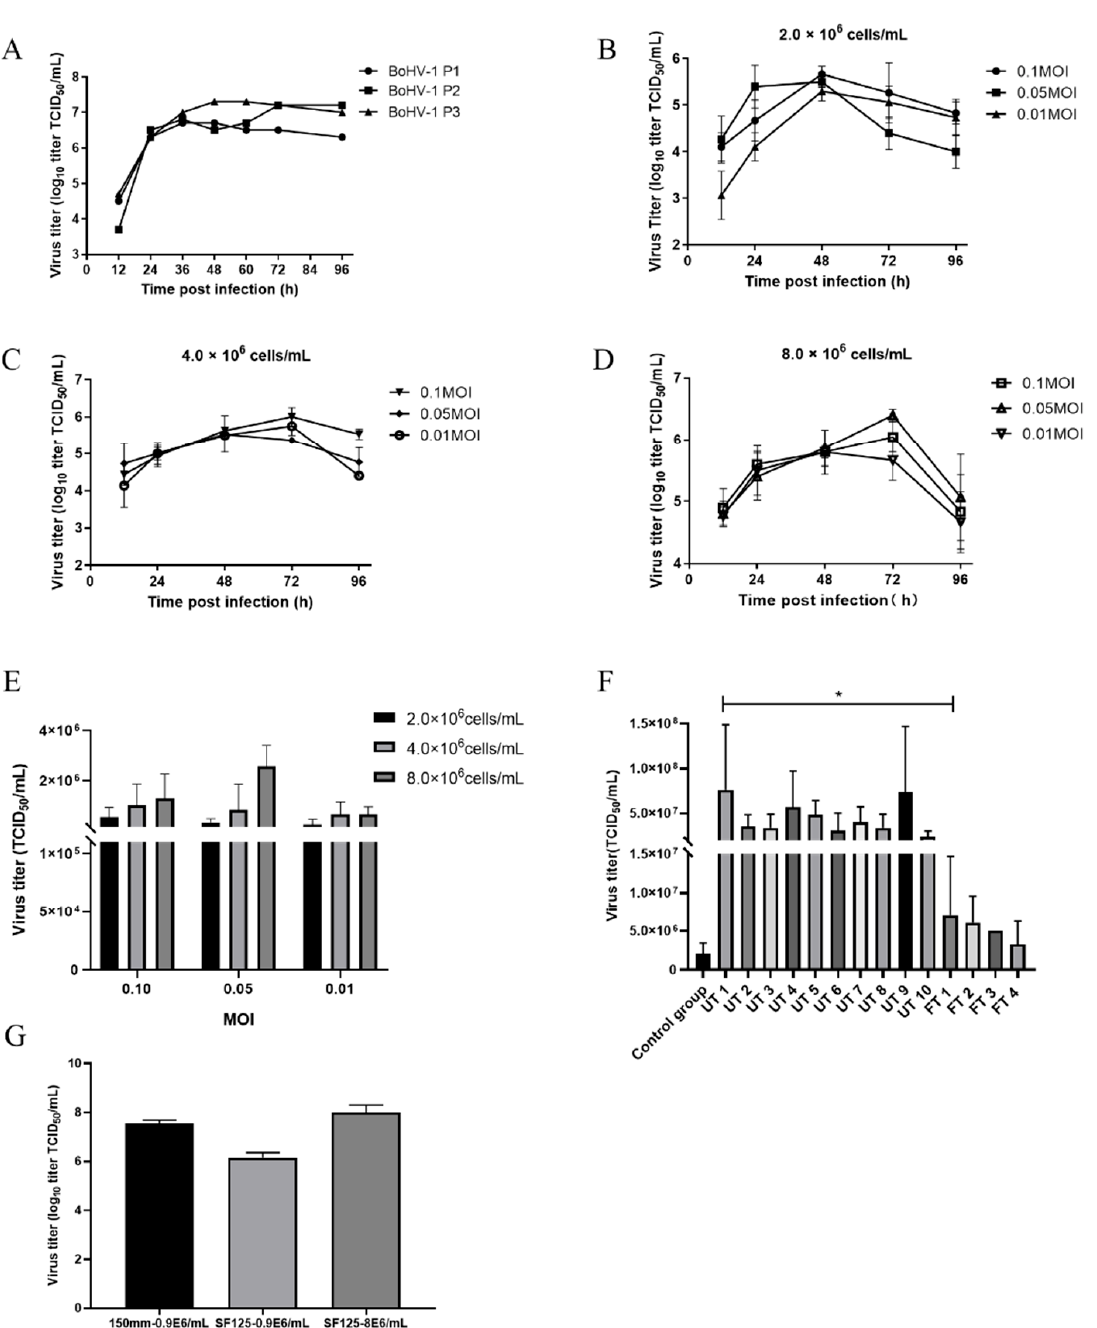
Figure 5. Optimization of BoHV-1 production in suspended MDBK cells cultivated in ST503 medium in shake flasks. ( A ) Virus adaptation: the changes in BoHV-1 titer (in log 10 TCID 50 /mL) after three passages of suspension adaptive culture; the changes in BoHV-1 titer (in log 10 TCID 50 /mL) for the 96 h post infection of suspended MDBK cells at concentrations of ( B ) 2.0 × 10 6 cells/mL, ( C ) 4.0 × 10 6 cells/mL and ( D ) 8.0 × 10 6 cells/mL with BoHV-1 seed virus in shake flasks at MOI of 0.1, 0.05 or 0.01. ( E ) Comparison of the highest virus yield obtained with different cell inoculation concentra- tions and MOIs. ( F ) Evaluation of different methods of virus release: the titer of infected cultures